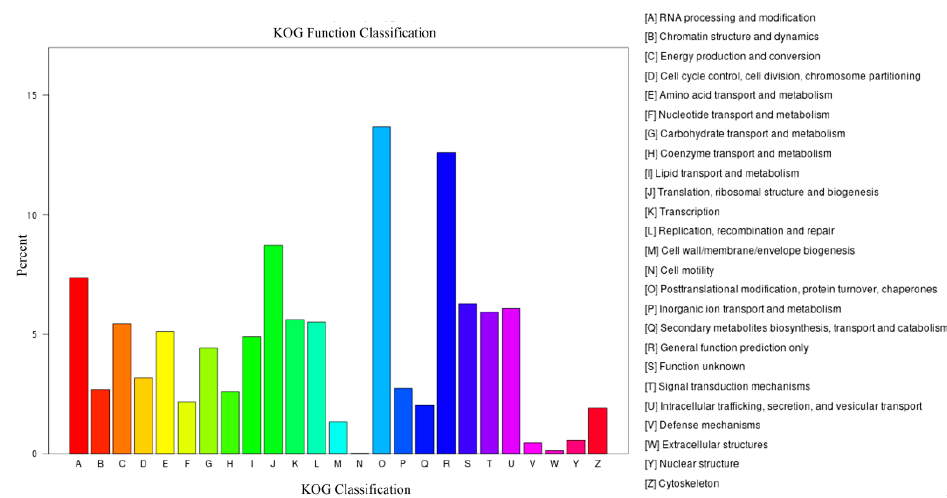
Figure 11. The functional annotation of unigenes in the KOG database.